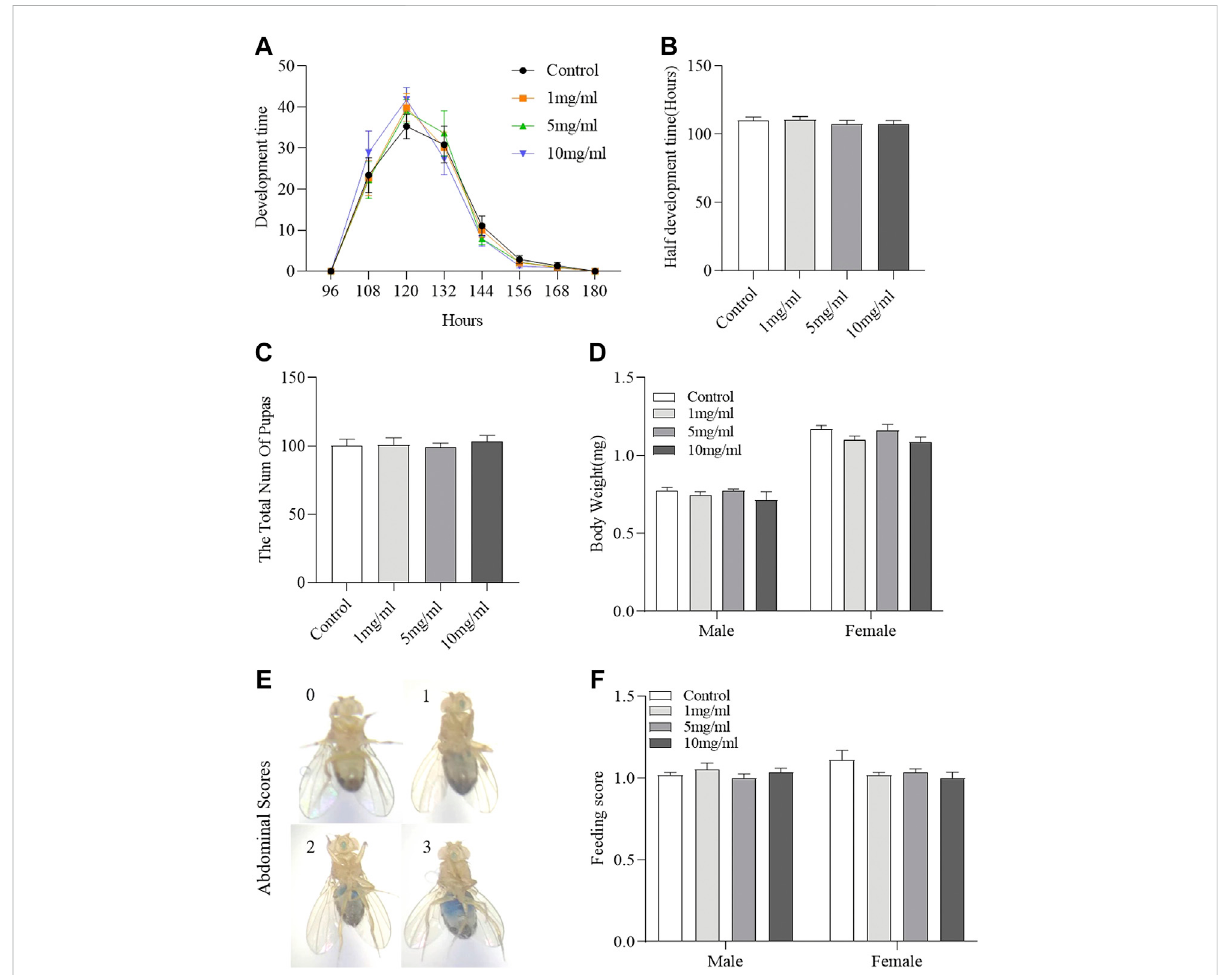
FIGURE 3 Daily intake of FPE does not affect development, body weight and food consumption. Flies were develop in standard foods (control groups), or foodssupplementedwithFPE(1,5,10 mg/L).During their development,pupationtime (A) ,half development timeof fl ies (B) andthetotalnumberof pupas (C) are recorded( n = 20). After eclosion of the fl ies fed the food with or withoutFPE, thebody weight ( n = 10) (D) and feed consumption (F) of adultfemalesandmalesisnotaffected( n =56 – 60). (E) Representativeexamplesof fl iesthatconsumeddifferentamountsoffood,visualizedas blue dye. The results are presented as the means ±